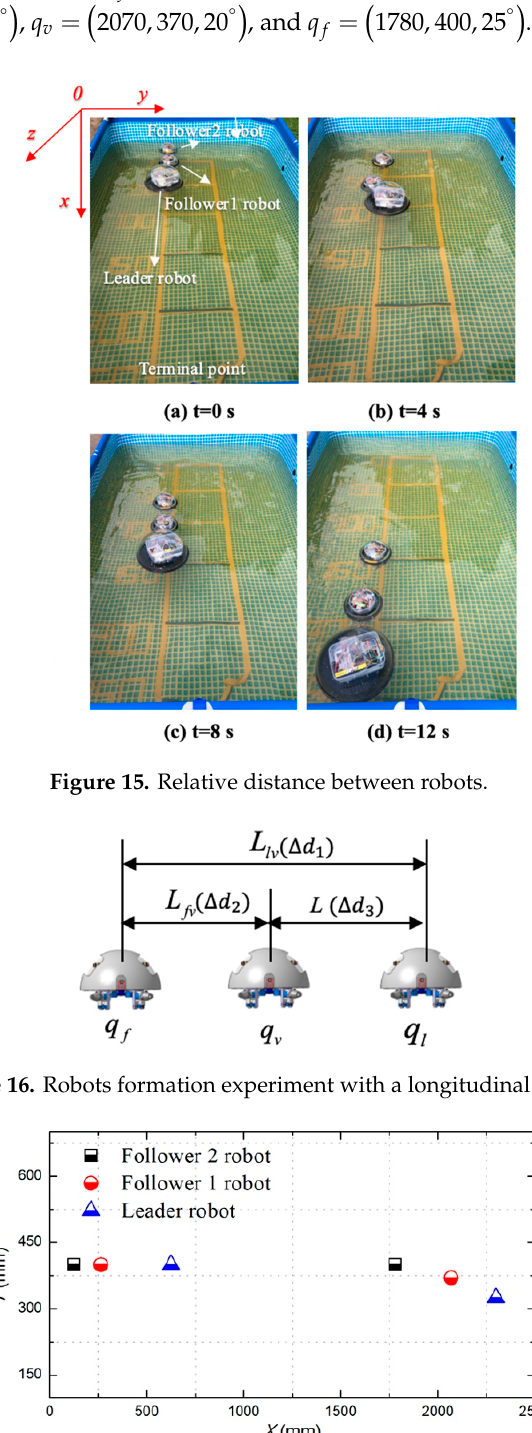
Figure 17. Calibration of the start and terminal coordinate (longitudinal queue).